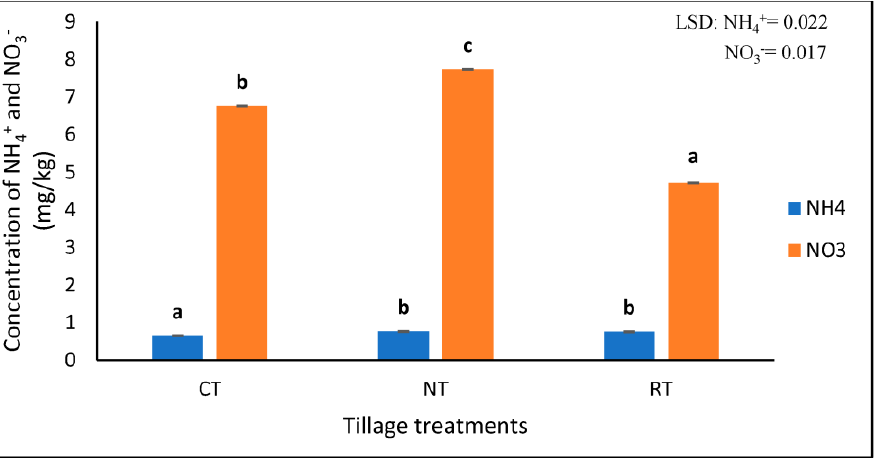
Figure 2. The concentrations of extractable NO 3 − and NH 4+ at three different tillage treatments of no-till (NT), rotational tillage (RT), and conventional tillage (CT) after 17 years of trial establishment. The bars not sharing the same letter differ significantly at LSD ( p = 0.05).